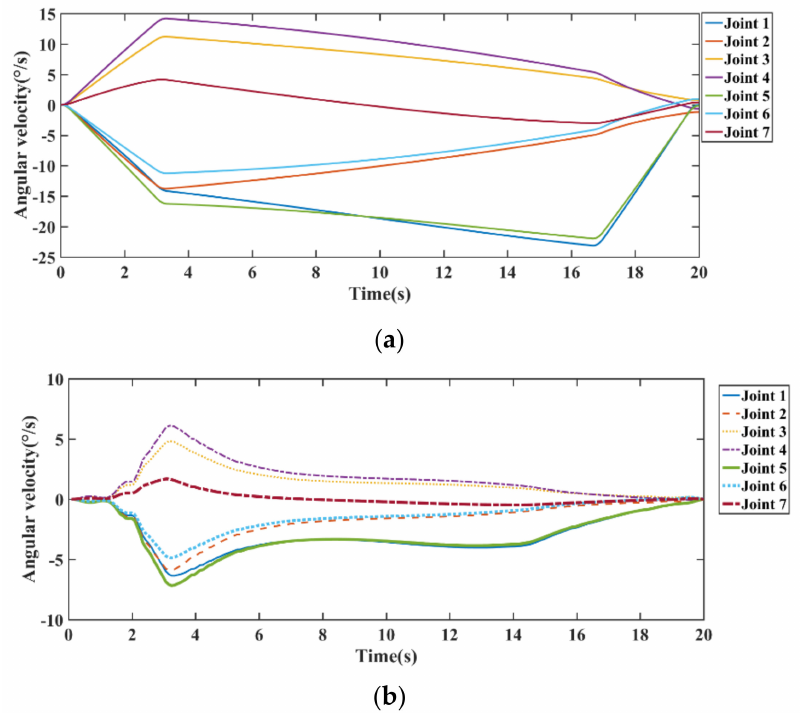
Figure 20. Joint angular velocity of trajectories. ( a ) Without optimization, ( b ) With